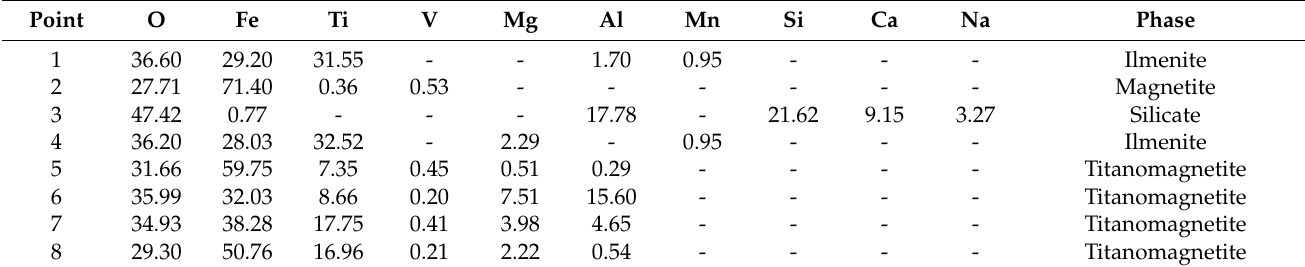
Figure 1. Microstructure and EDS results of VTMC: ( a ) typical SEM image; ( b ) partial enlarged view of ( a ), where “+” refers to the analyzed point through EDS, and numbers refer to the composition data in Table 2. Table 2. Elemental composition of VTMC